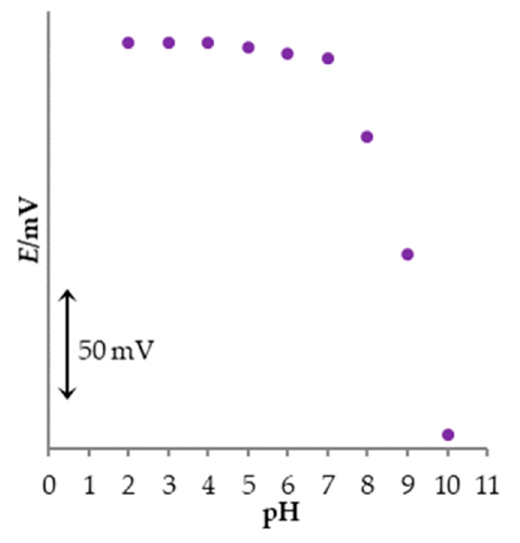
Figure 4. The influence of the pH value on the response of the new PM sensor.